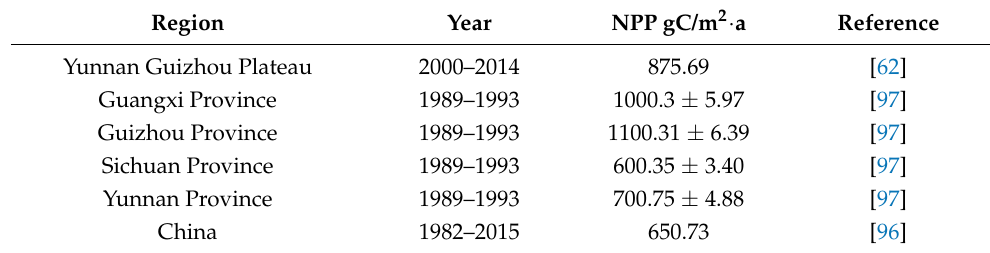
Table 6. Summary of the annual average NPP of forests in Southwest China and China.